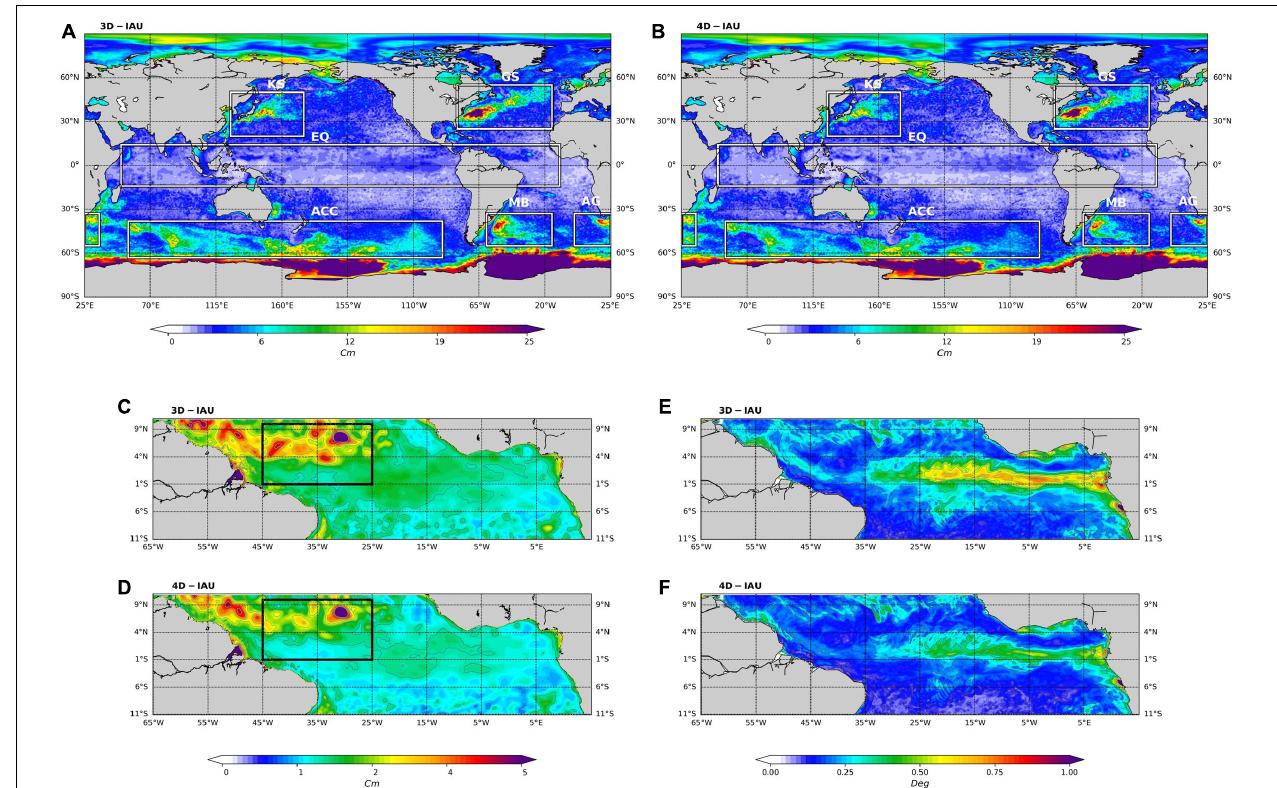
FIGURE 12 | Root Mean Square of the SSH Error; 3D-IAU in the panel (A) and 4D-IAU in the panel (B) Gulf Stream (GS), Brazil-Malvinas confluence (MB), Kuroshio (KS) and Agulhas (AG) retroflexion, the Antarctic Circumpolar Current (ACC), and the equatorial band (EQ). Root Mean Squared of the SSH error (C,D) and SST error (E,F) . (C–E) for the 3D-IAU and D-F for the 4D-IAU.